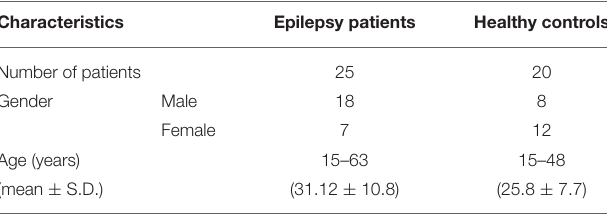
TABLE 1 | Clinical characteristics of epilepsy patients and healthy